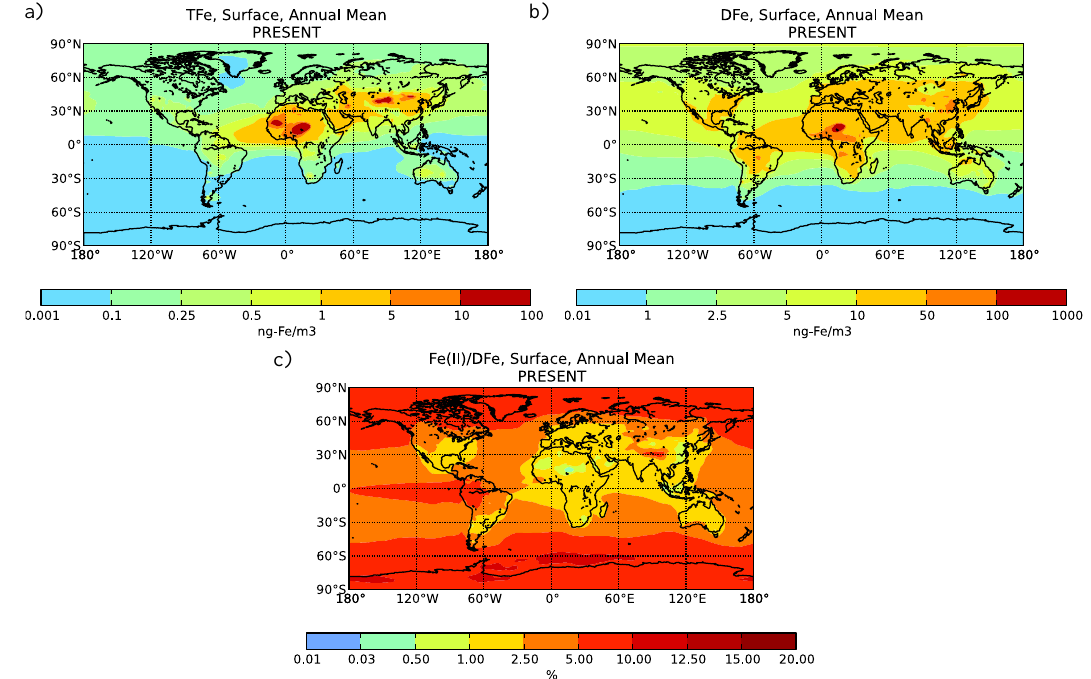
Figure 4. Annual averaged (a) proton-promoted and (b) ligand-promoted mineral-Fe dissolution flux (in ng-Fem − 2 s − 1 ) as calculated by TM4-ECPL for the present